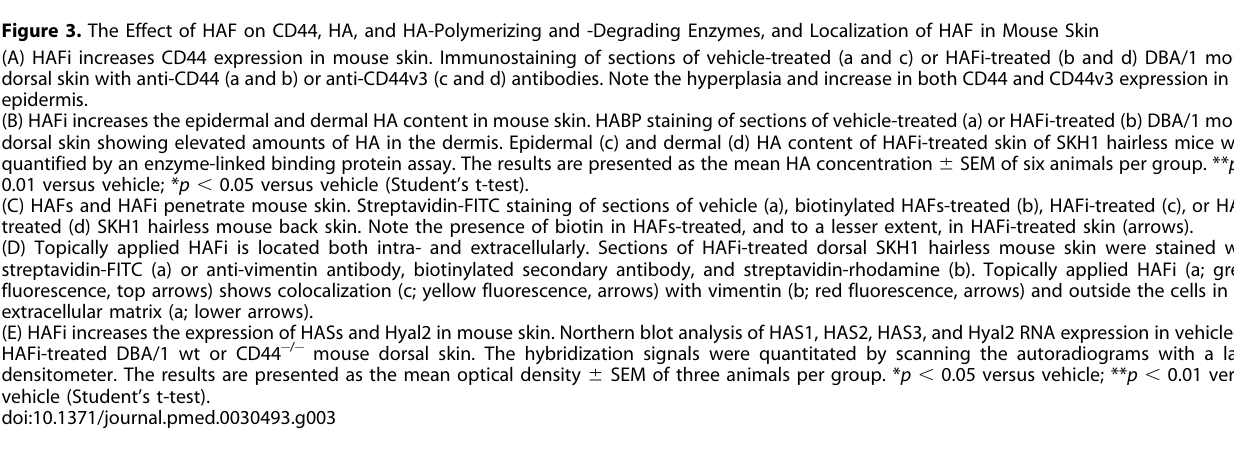
Figure 3. The Effect of HAF on CD44, HA, and HA-Polymerizing and -Degrading Enzymes, and Localization of HAF in Mouse Skin (A) HAFi increases CD44 expression in mouse skin. Immunostaining of sections of vehicle-treated (a and c) or HAFi-treated (b and d) DBA/1 mouse dorsal skin with anti-CD44 (a and b) or anti-CD44v3 (c and d) antibodies. Note the hyperplasia and increase in both CD44 and CD44v3 expression in the epidermis. (B) HAFi increases the epidermal and dermal HA content in mouse skin. HABP staining of sections of vehicle-treated (a) or HAFi-treated (b) DBA/1 mouse dorsal skin showing elevated amounts of HA in the dermis. Epidermal (c) and dermal (d) HA content of HAFi-treated skin of SKH1 hairless mice were quantified by an enzyme-linked binding protein assay. The results are presented as the mean HA concentration 6 SEM of six animals per group. ** p , 0.01 versus vehicle; * p , 0.05 versus vehicle (Student’s t-test). (C) HAFs and HAFi penetrate mouse skin. Streptavidin-FITC staining of sections of vehicle (a), biotinylated HAFs-treated (b), HAFi-treated (c), or HAFl- treated (d) SKH1 hairless mouse back skin. Note the presence of biotin in HAFs-treated, and to a lesser extent, in HAFi-treated skin (arrows). (D) Topically applied HAFi is located both intra- and extracellularly. Sections of HAFi-treated dorsal SKH1 hairless mouse skin were stained with streptavidin-FITC (a) or anti-vimentin antibody, biotinylated secondary antibody, and streptavidin-rhodamine (b). Topically applied HAFi (a; green fluorescence, top arrows) shows colocalization (c; yellow fluorescence, arrows) with vimentin (b; red fluorescence, arrows) and outside the cells in the extracellular matrix (a; lower arrows). (E) HAFi increases the expression of HASs and Hyal2 in mouse skin. Northern blot analysis of HAS1, HAS2, HAS3, and Hyal2 RNA expression in vehicle- or HAFi-treated DBA/1 wt or CD44 (cid:1) / (cid:1) mouse dorsal skin. The hybridization signals were quantitated by scanning the autoradiograms with a laser densitometer. The results are presented as the mean optical density 6 SEM of three animals per group. * p , 0.05 versus vehicle; ** p , 0.01 versus vehicle (Student’s